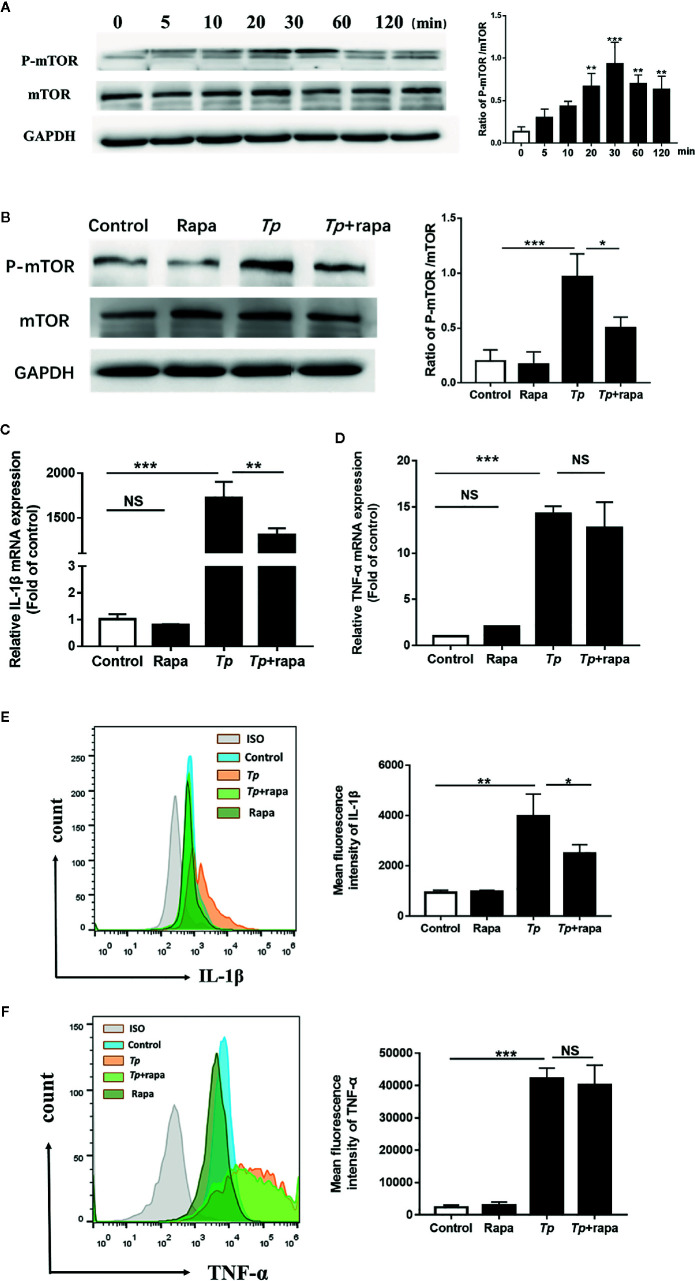
mTOR, but not autophagy, was essential for the expression of IL-1β induced by Tp. (A) THP-1 cells were incubated with Tp at an MOI of 10 for different amounts of time, and the levels of phosphorylated and total mTOR protein were detected by Western blotting. (B) THP-1 cells were pre-treated with Rapa (50 nM) for 30 min and then incubated with Tp at an MOI of 10 for 30 min. The levels of phosphorylated and total mTOR protein were detected by Western blotting. (C, D) THP-1 cells were pre-treated with Rapa (50 nM) for 30 min and then incubated with Tp at an MOI of 10 for 12 h. The levels of IL-1β and TNF-α were evaluated by RT-PCR. (E, F) The protein expression of IL-1β and TNF-α was detected by flow cytometry. (*P < 0.05; **P < 0.01; ***P < 0.001).